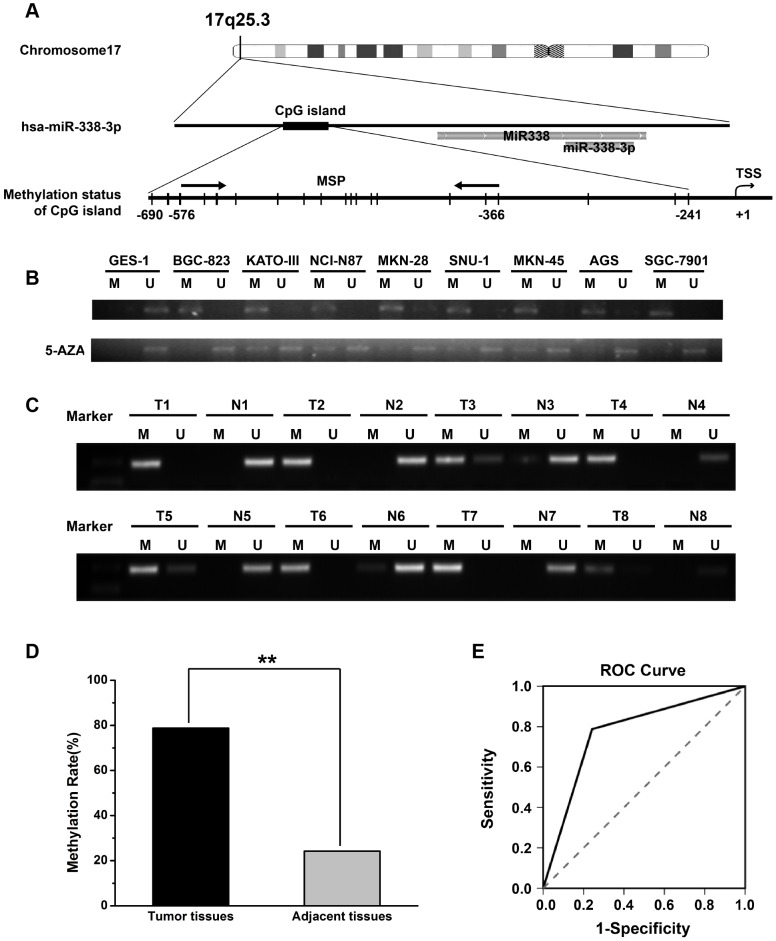
Methylation status of miR-338-3p CpG island.(A) Schematic locations of CpG sites within the CpG islands that surround the miR-338-3p promoter region. (B) MSP analysis for miR-338-3p methylation in GC cell lines. M: MSP of methylation-specific primers; U: MSP of non-methylation-specific primers (C) Representative results of MSP analysis of miR-338-3p in gastric cancer tissues (T) and adjacent normal tissues (N). (D) Methylation levels of miR-338-3p CpG island in GC tumor tissues and matched adjacent non-tumor tissues in 66 patients (78.79% and 24.24%, **P<0.01). (E) The receiver operating characteristics curve of methylation status of miR-338-3p. The AUC was 0.773±0.042 (P<0.001), 95% confidence interval was (0.690, 0.856).